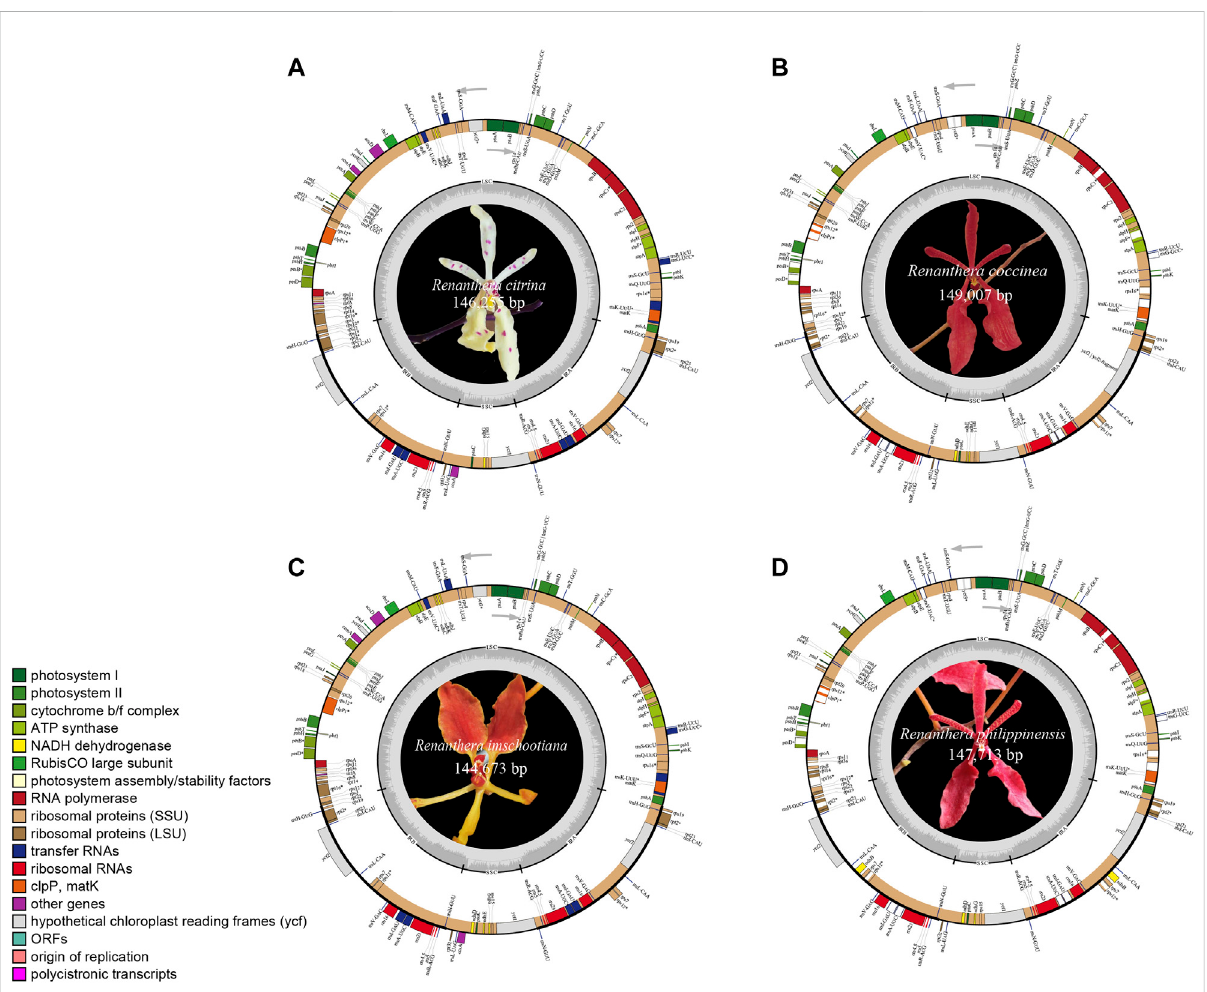
FIGURE 1 Genemapofplastidgenomesoffourspeciesof Renanthera usedinthisstudy,including (A) R.citrina ; (B) R.coccinea ; (C) R.imschootiana ; (D) R. philippinensis .Genesoninsideofmaparetranscribedinclockwisedirection;genesonoutsideofmaparetranscribedincounterclockwisedirection. Different functional groups of genes are shown in different colors. Inverted repeat (IR), small single-copy (SSC), and large single-copy (LSC) regions are